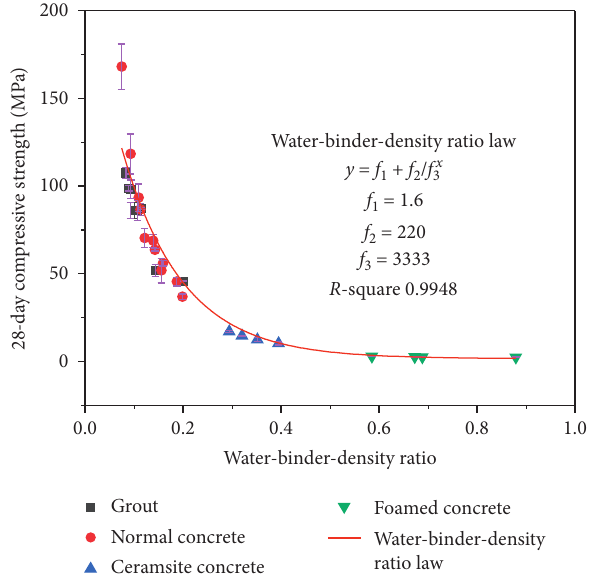
Figure 12: Simulation of water-binder-density ratio law for all cement-based